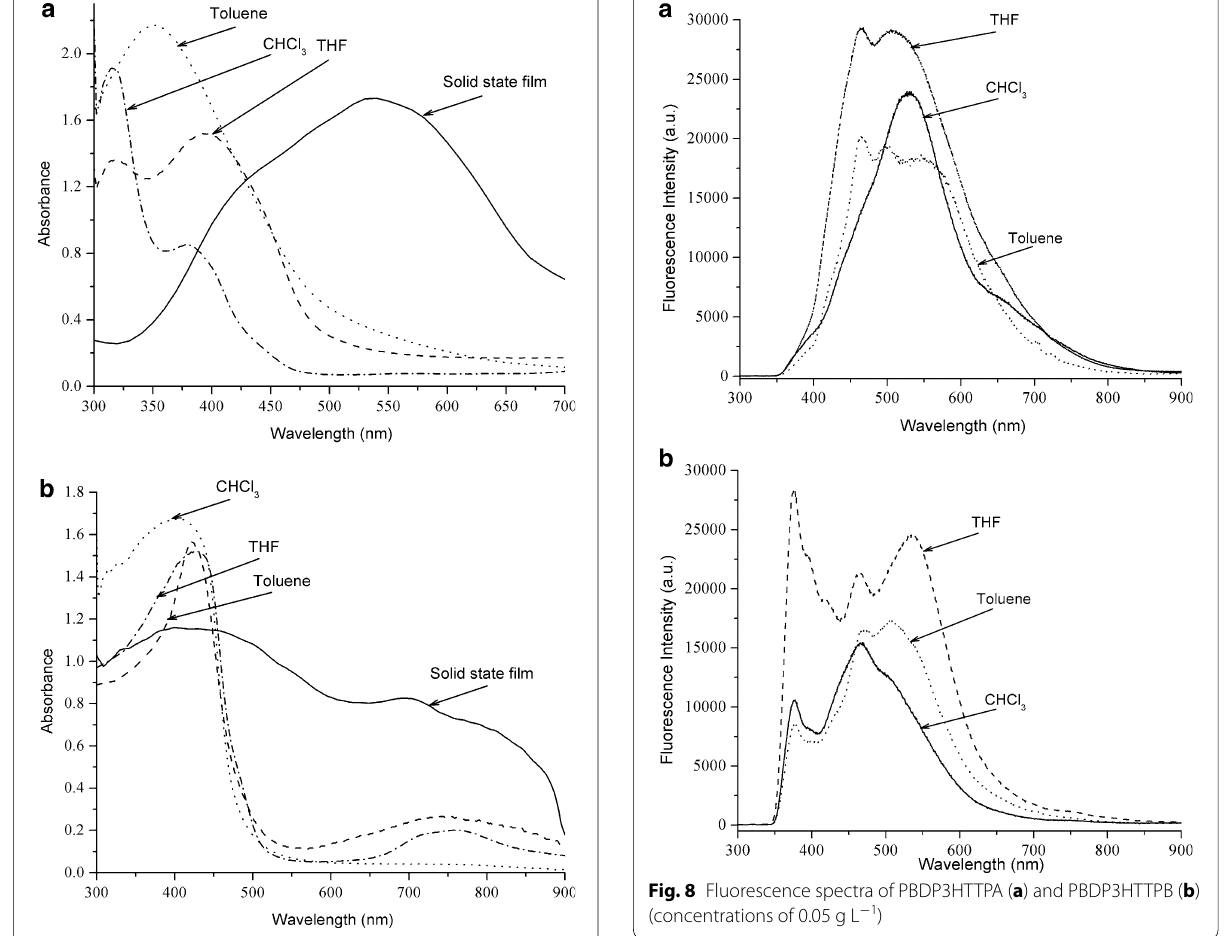
Fig. 7 Absorption spectra of PBDP3HTTPA ( a ) and PBDP3HTTPB ( b ) in different solvents and solid state films